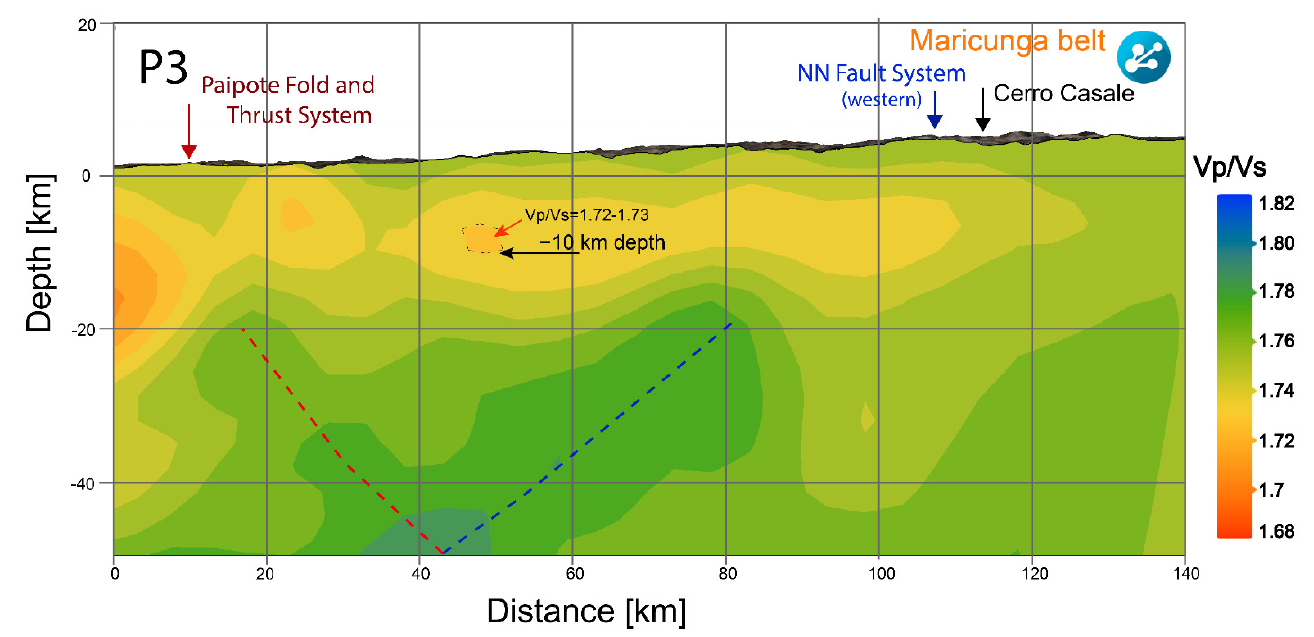
Figure 6. Cross section of the Vp/Vs model (with color intervals of 0.01) passing through the Cerro